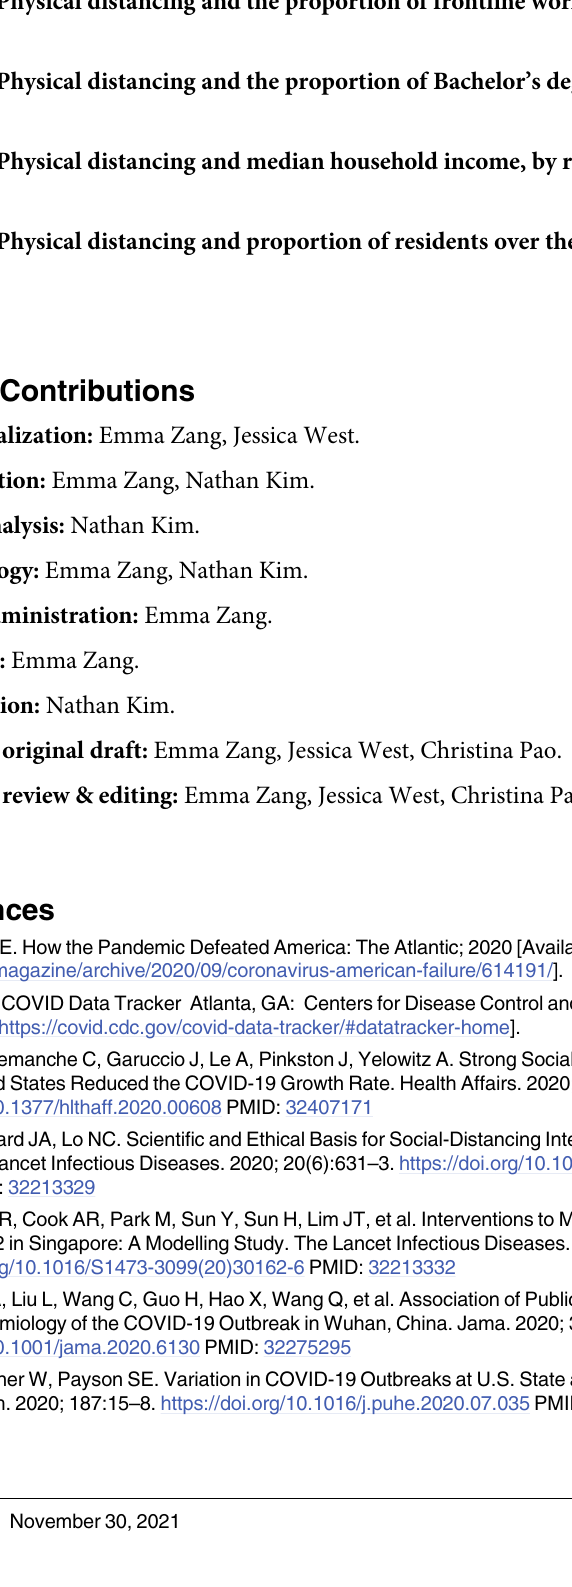
S1 Table. Physical distancing and proportion Black, by region. S2 Table. Physical distancing and the proportion of frontline workers, by region. S3 Table. Physical distancing and the proportion of Bachelor’s degree holders, by region. S4 Table. Physical distancing and median household income, by region. S5 Table. Physical distancing and proportion of residents over the age of 65, by